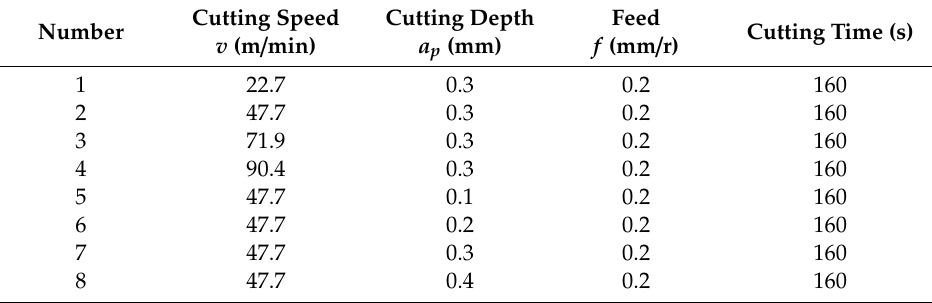
Table 4. The experimental cutting parameters.